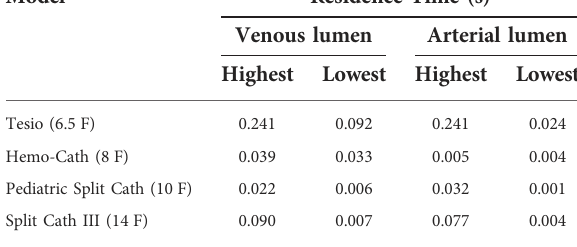
TABLE 2 Rt values recorded at the side-holes of the CVLs.